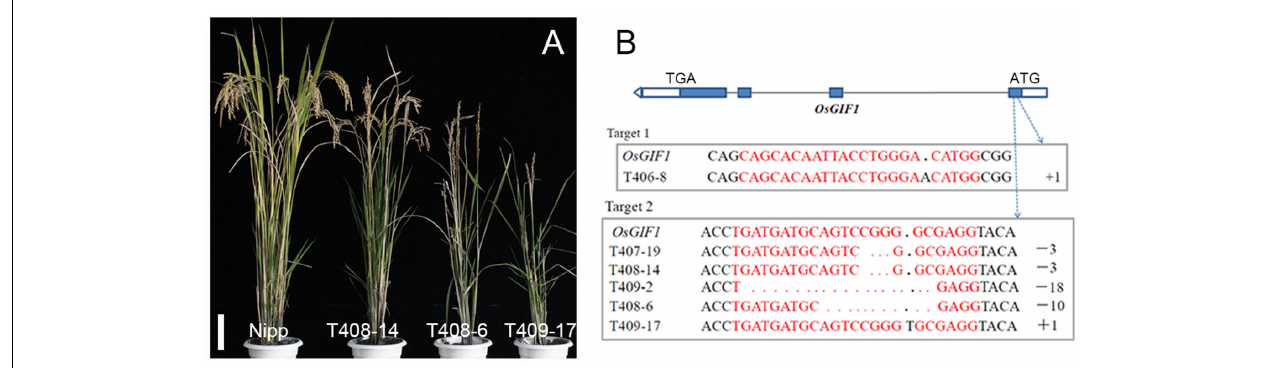
FIGURE 1 | Knock-out (KO) of OsGIF1 by a CRISPR/Cas9 strategy. (A) Comparisons of the OsGIF1 KO plants, scale bar: 10 cm; (B) Identification of mutation by direct sequencing of target sites in transgenic